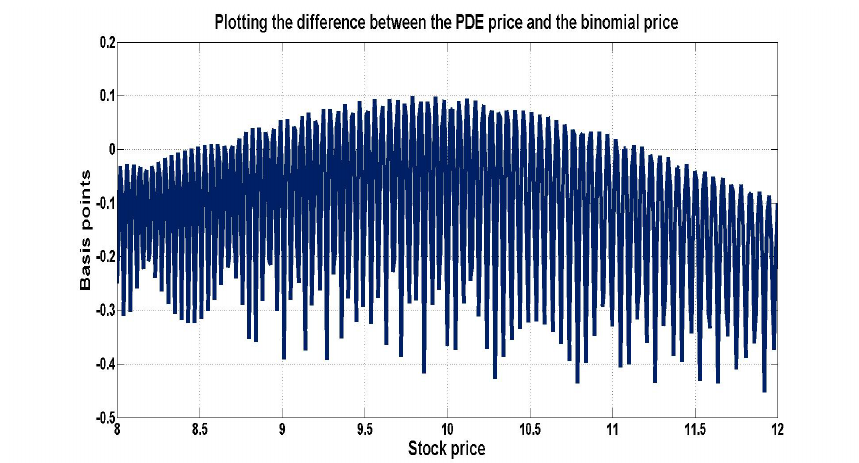
Figure 9. Difference between the PDE price and the binomial lattice price for a collateralized European put option with parameters: S increments), ds = 0 . 02 (1000 space increments), T = 0 . 5 , r r = 0 . 01 , σ = 0 . 3 and θ = 1 D